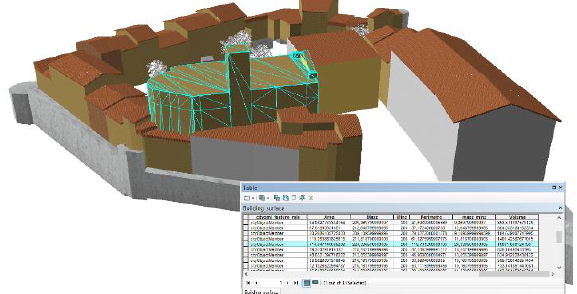
Figure 4. 3D query and analysis tools in GIS environments